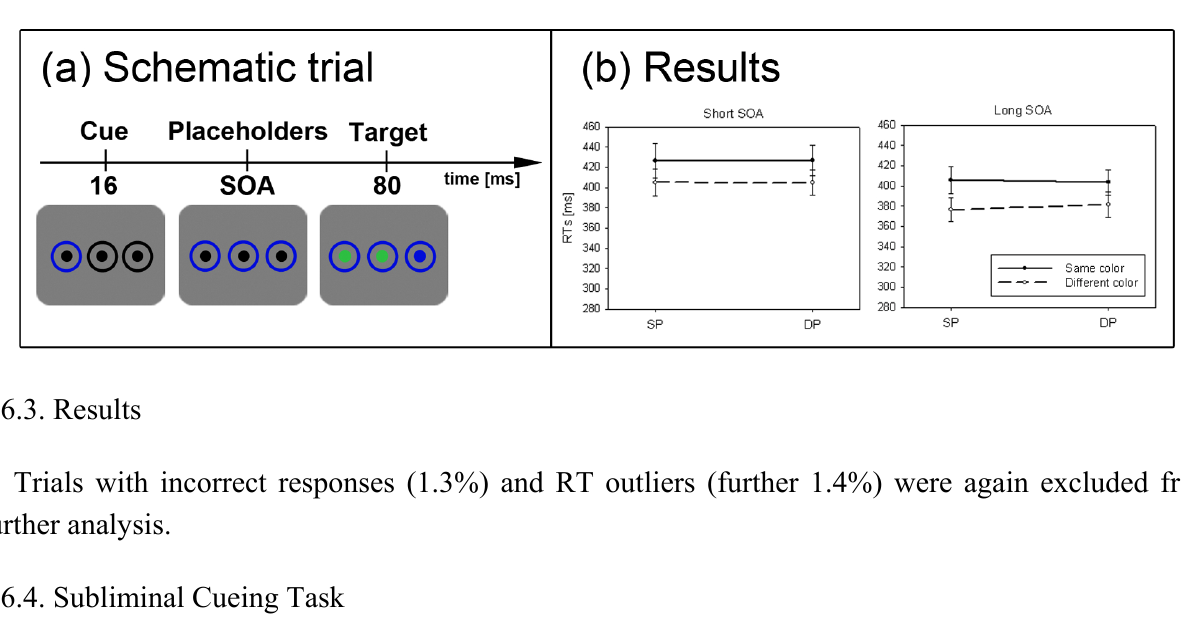
same-color cue). ( b ) Depicted are the mean RTs and standard errors of the mean (error bars) of all participants. Results are plotted separately for the short (left panel) and long SOA (right panel), for same color cues (solid line) and cues of a different color (dashed